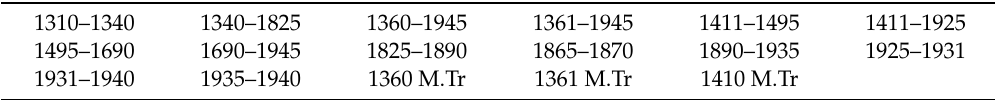
Table A1. Monitoring branches for HVDC